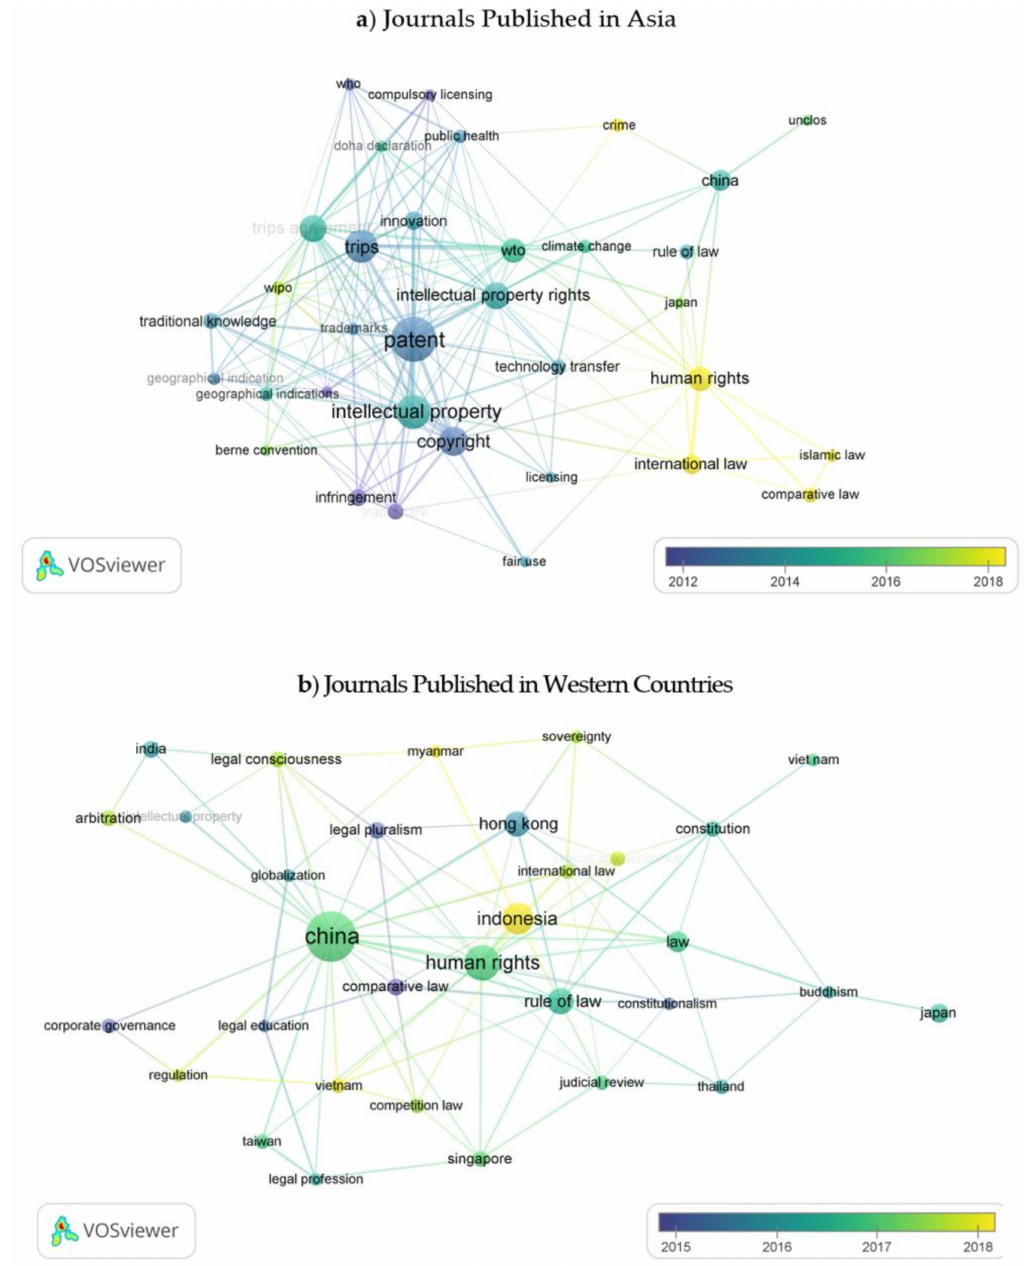
Figure 1. VOSViewer Representation of Author Keywords of Asian Law